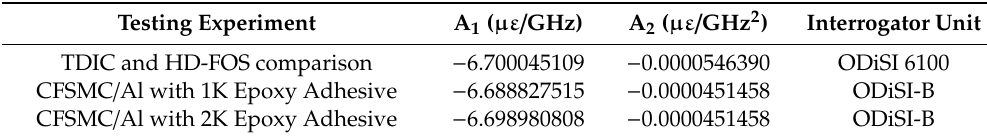
Table 5. Calibration coe ffi cients, A 1 and A 2 , used to convert spectral shift (GHz) values to strain ( µε ) values for the CFSMC and CFSMC / Al with epoxy adhesives smart